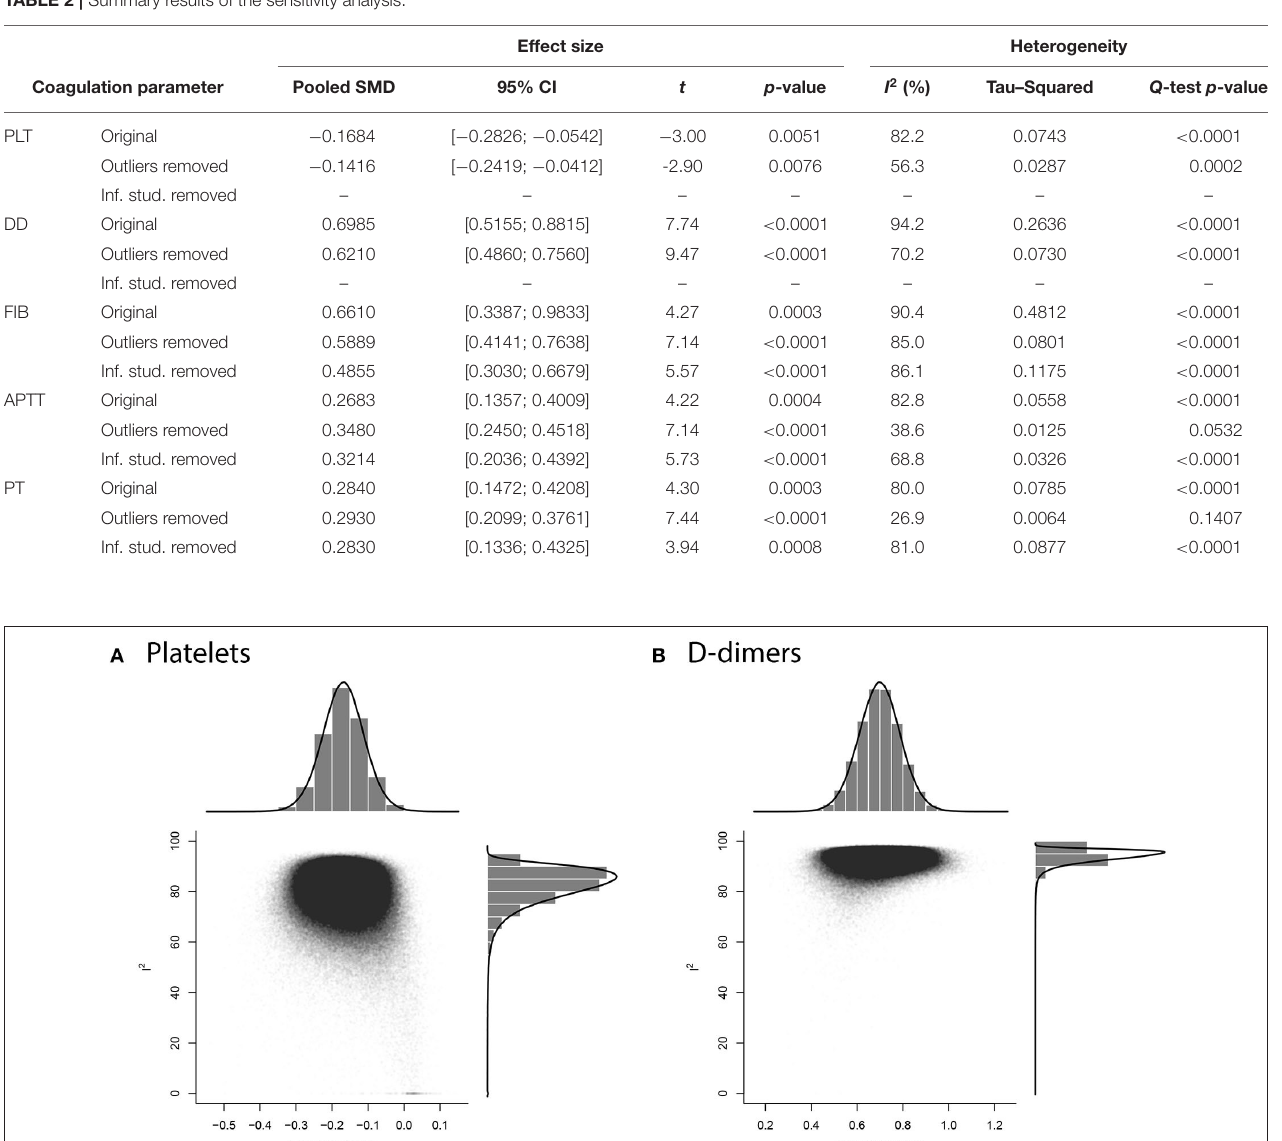
TABLE 2 | Summary results of the sensitivity analysis.